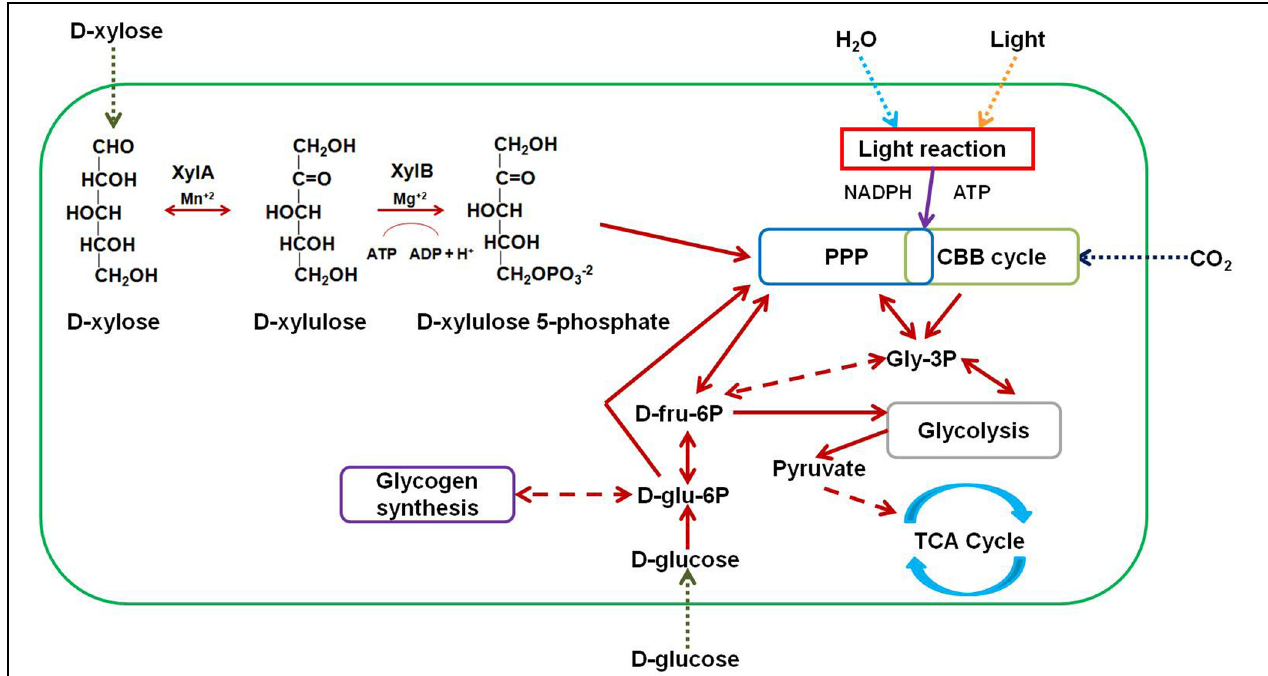
FIGURE 1 | Metabolic scheme for engineering Synechocystis strains. D -xylose enters the transformant strains by means of native and heterologous transporters. Direction of entry of sugars, water, inorganic carbon (CO 2 ), and light into the cell is shown as dotted arrows. D -xylose is converted to D -xylulose by D -xylose isomerase (XylA) in the presence of manganese ions (Mn + 2 ). D -xylulose is further converted to D -xylulose 5-phosphate by the action of D -xylulokinase (XylB) in the presence of magnesium ions (Mg + 2 ). D -xylulose 5-phosphate then enters the PPP. Bidirectional arrows indicate a reversible reaction or ability of an intermediate to enter and exit a pathway. Unidirectional arrows indicate a non-reversible reaction or the ability of an intermediate to either enter or exit a pathway. Dashed arrows indicate the involvement of one or more intermediates. Other abbreviations: CBB cycle, Calvin–Benson–Bassham cycle; ATP, adenosine triphosphate; NADPH, nicotinamide adenine dinucleotide phosphate; Gly-3P, glyceraldehyde 3-phosphate; D -fru-6P, D -fructose 6-phosphate; D -glu-6P, D -glucose 6-phosphate; TCA cycle, tricarboxylic acid cycle.